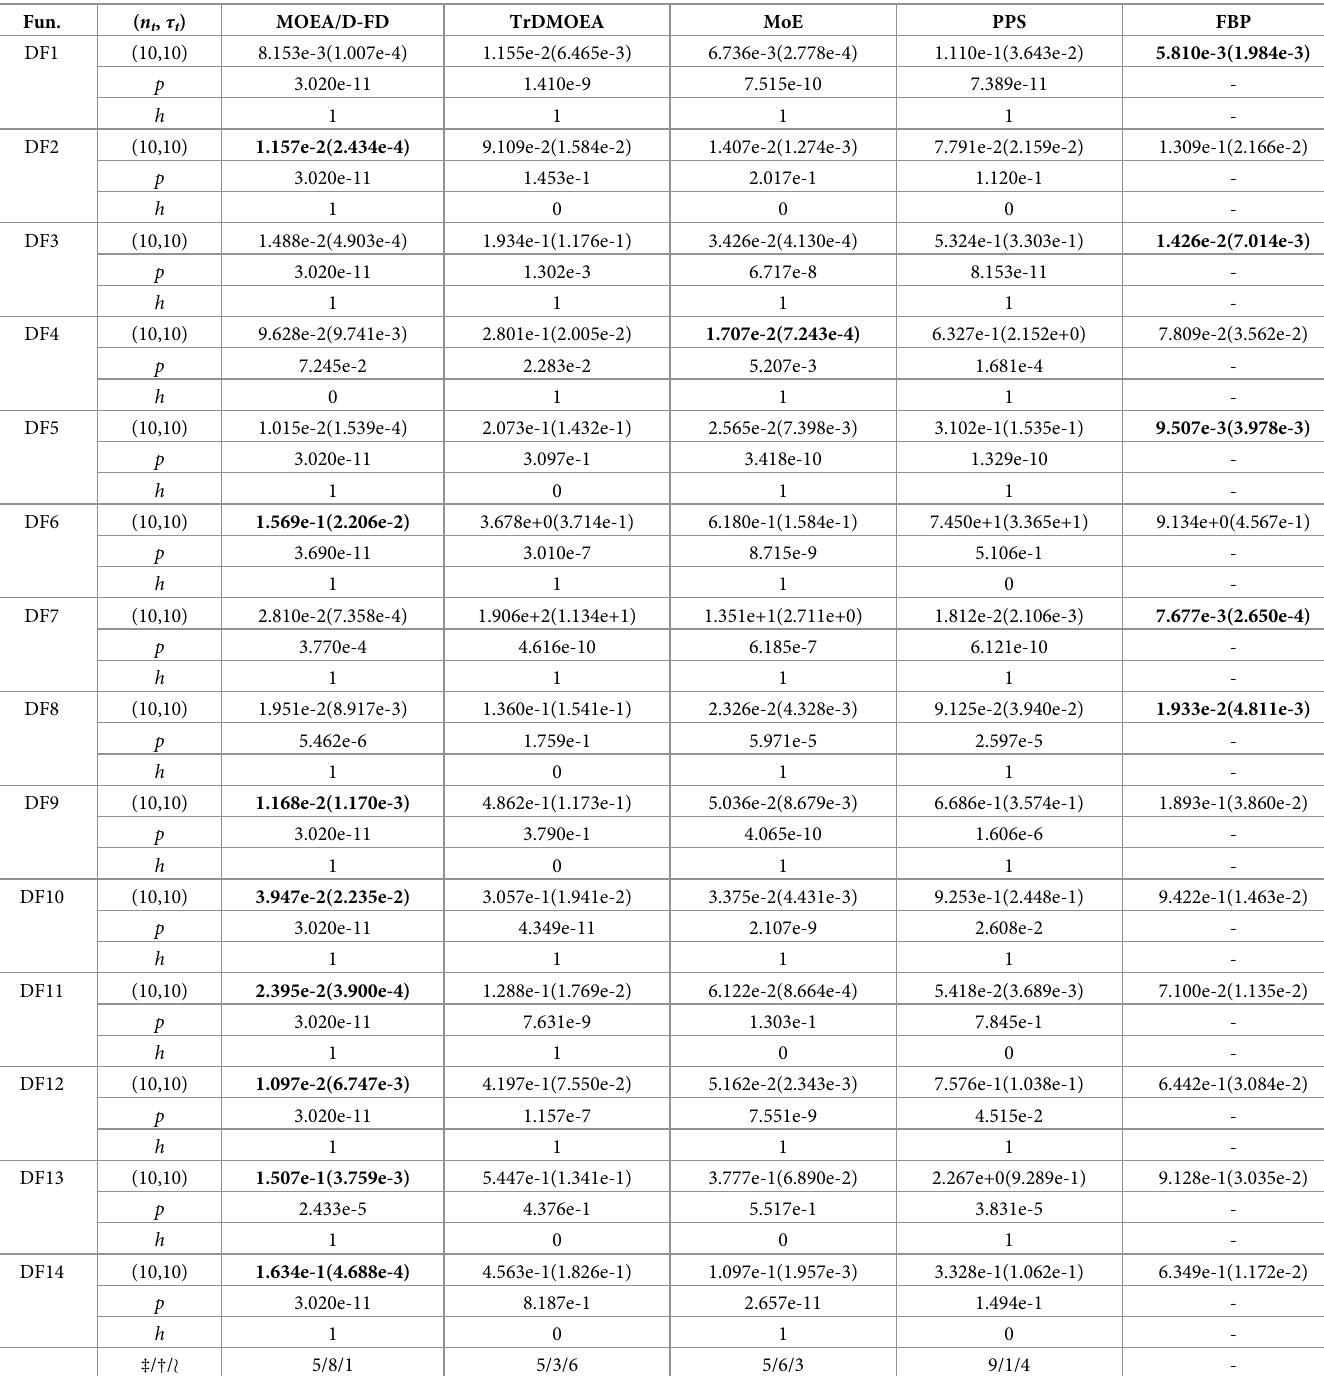
Table 8. Mean and standard deviation values of MSP obtained by five algorithms for ( n t , τ t ) = (10,10).